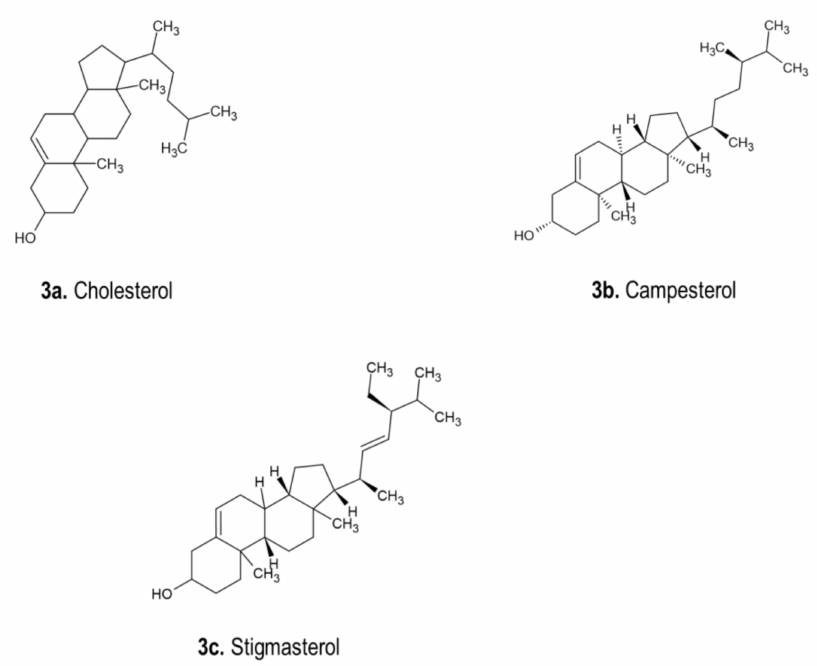
Figure 3. Chemical structures of phytosterols isolated from Drimia spp. [1]. ( a ). Cholesterol (C 27 H 46O ); ( b ). Campesterol (C 28 H 48O ); ( c ). Stigmasterol (C 29 H 48O